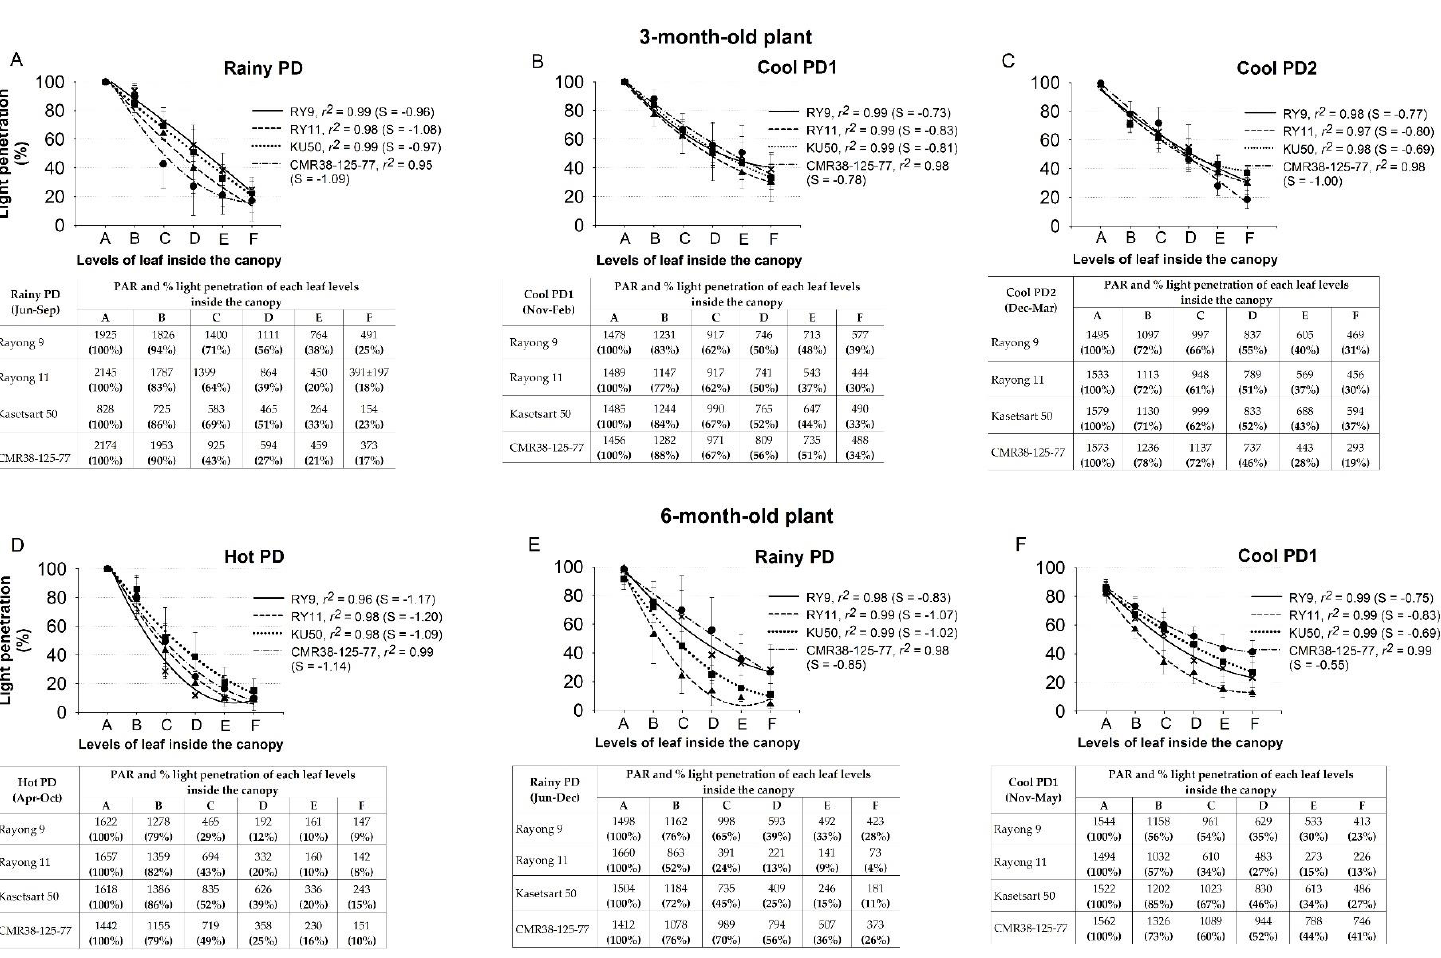
), Rayong 11 Figure 3. Percentage of light penetration through different canopy layers (Levels A – F) of the 3- and 6-month-old plants of cassava Rayong 9 (RY9;